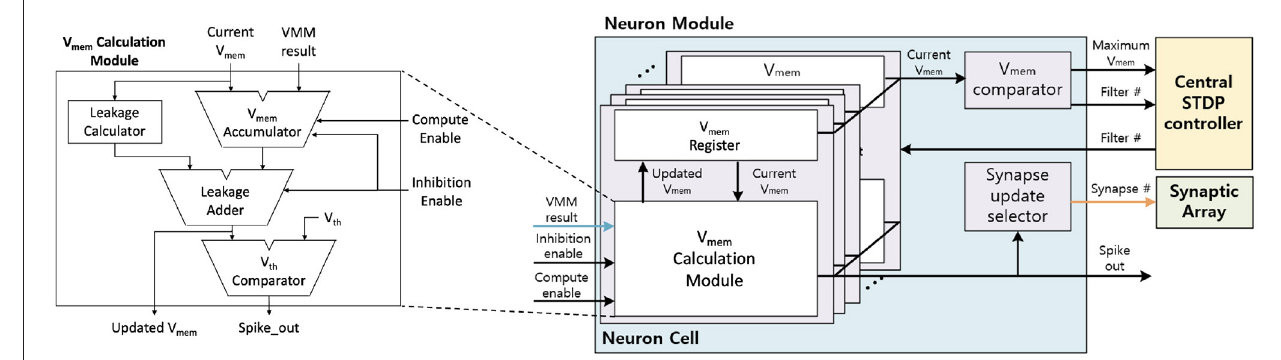
FIGURE 10 | The LIF Neuron Module